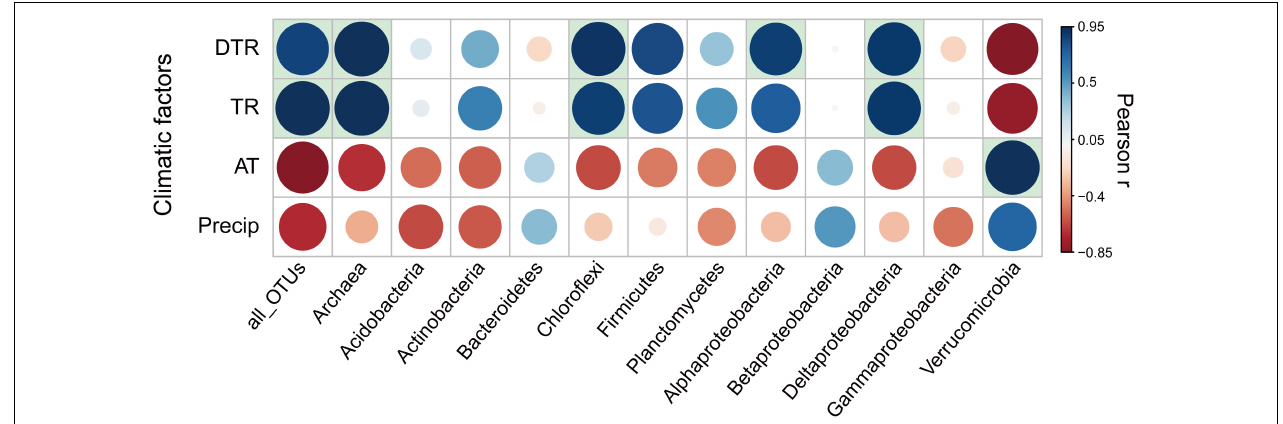
FIGURE 3 | Pearson correlation coefficients ( r ) between temporal turnover rate for each phylogenetic group of microbial communities and climatic factors. The significant ( P < 0.05) correlation coefficients were indicated by filling the background of the grid with light blue. DTR, intra-seasonal mean diurnal temperature range; TR, intra-seasonal temperature range; AT, intra-seasonal mean temperature; Precip, intra-seasonal sum of precipitation.